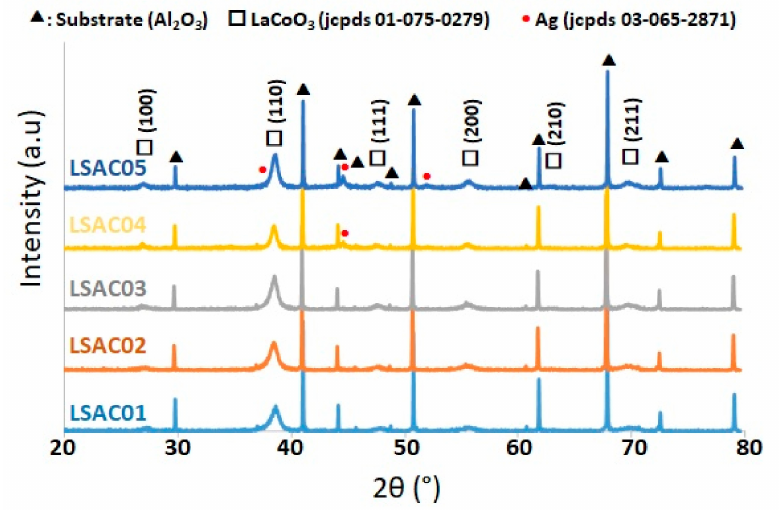
Figure 6. XRD patterns after the calcination treatment at 500 ◦ C for 2 h under air of the di ff erent LSACO